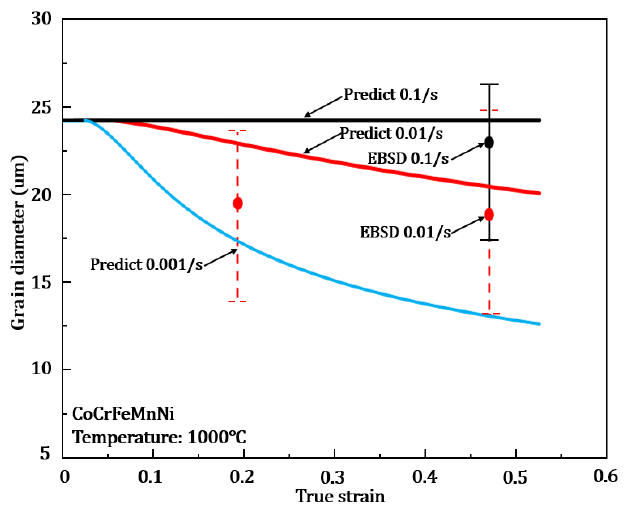
Figure 6. Comparisons of grain size between EBSD obversion and model results in various deformation conditions.